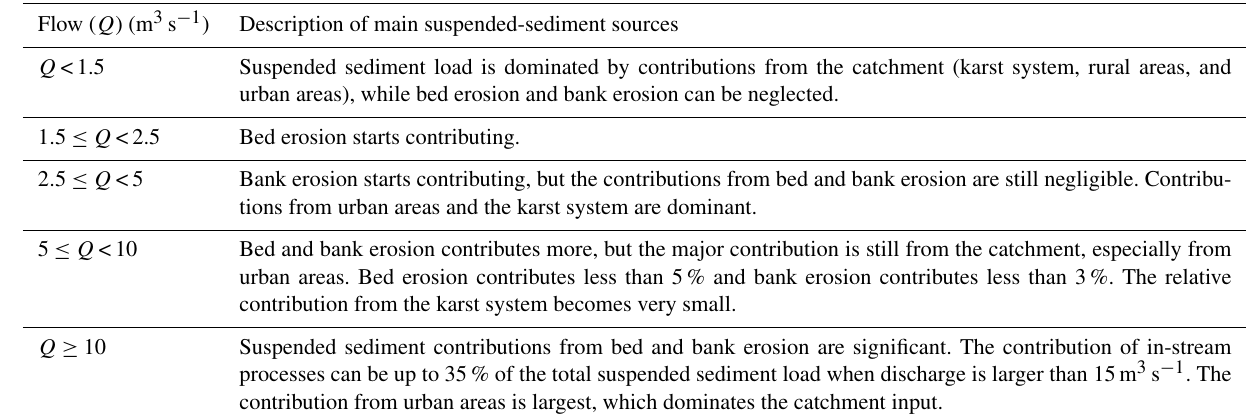
Table 4. Summary of suspended-sediment sources under different flow conditions.